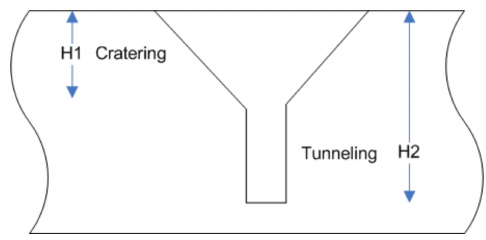
Figure 6. Two-stage penetration